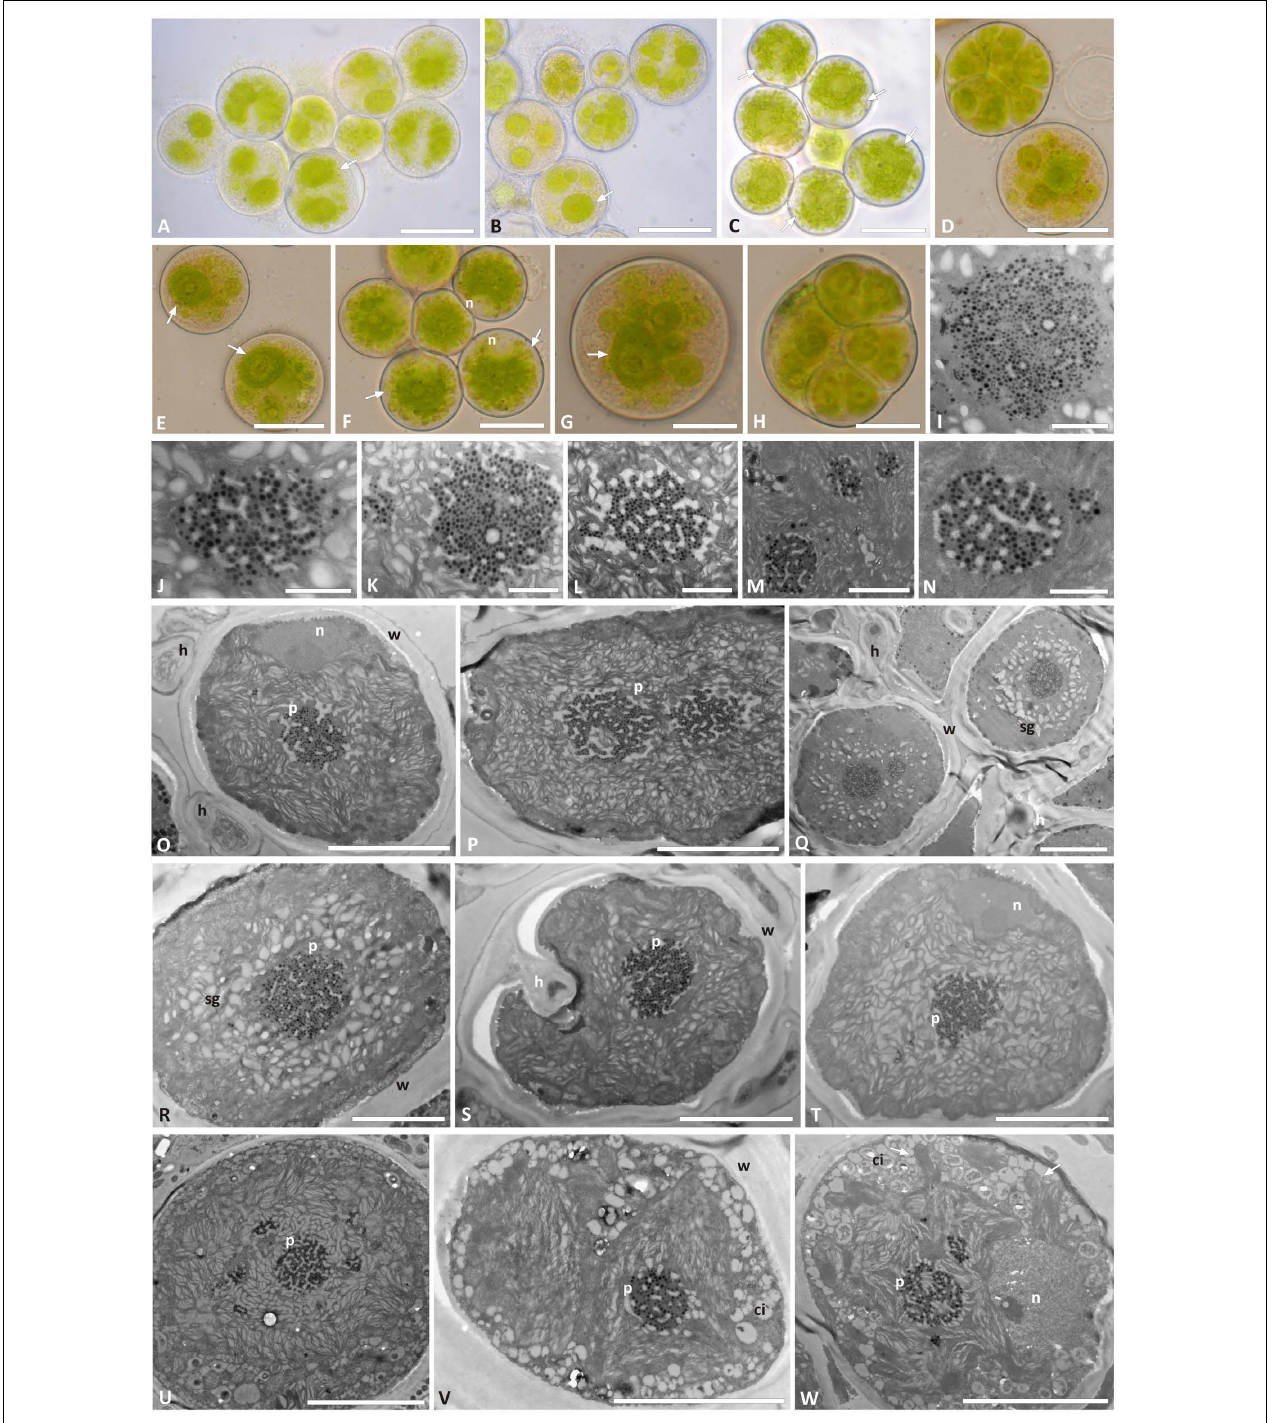
FIGURE 4 | Morphology and pyrenoid ultrastructure of Trebouxia “A52” isolated in axenic culture and in the corresponding original thalli. DNA extraction numbers ( Table 1 and Supplementary Table 2 ) identify the samples as follows: (A–C,U) culture L2918(*3); (D–F,W) culture L2906(*2); (G,H,M,V) culture L2903(*2); (I,Q,R) from thallus L2388(*2); (J,K,S,T) from thallus L2385(*1); (L,O,P) from thallus L2389(*3); (N) culture L2912(*1). (A–G) Cultured algal cells observed by light microscopy: arrows indicate the lobes of the chloroplast (central green body) and the nucleus. (H) Asexual autospore cells. (I–W) TEM microphotographs of algal cells: (I–N) detail of pyrenoid ultrastructure of gigantea type; (O–S) algal cells from thallus; (T–W) axenically cultured algae. The letters indicate cytoplasmic inclusion (ci), mycobiont hyphae (h), nucleus (n), pyrenoid (p), starch grain (sg), and cell wall (w); multiple pyrenoid bodies are visible in panels (M,P,Q,U,W) . Scale bars: (A–C) 20 µ m; (D–F,U) 10 µ m; (G,H,O–T,V,W) 5 µ m; (M) 2 µ m; (I–L,N) 1 µ